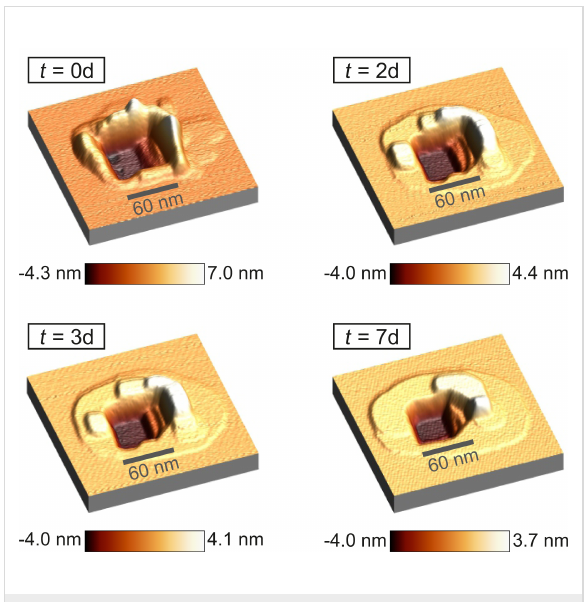
Figure 4: 200 nm × 200 nm 3D profile image of the generated scratching site directly taken after generating, after two, three and seven days at 3.0 < RH < 5.5%. The lowest levels of the hole fill until the second measurement, yet the maximum depth remains constant afterwards. The higher levels accumulated material erodes more quickly. A spread of the material around the defect can be observed. Measurement parameters: f 0 = 31785 Hz, A = 500 pm, Δ f = 25 Hz.